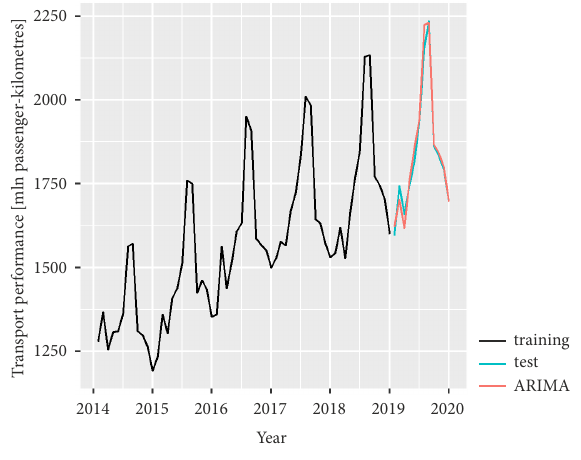
Figure 5. ARIMA ((1, 0, 0) (0, 1, 0) [12]) forecast